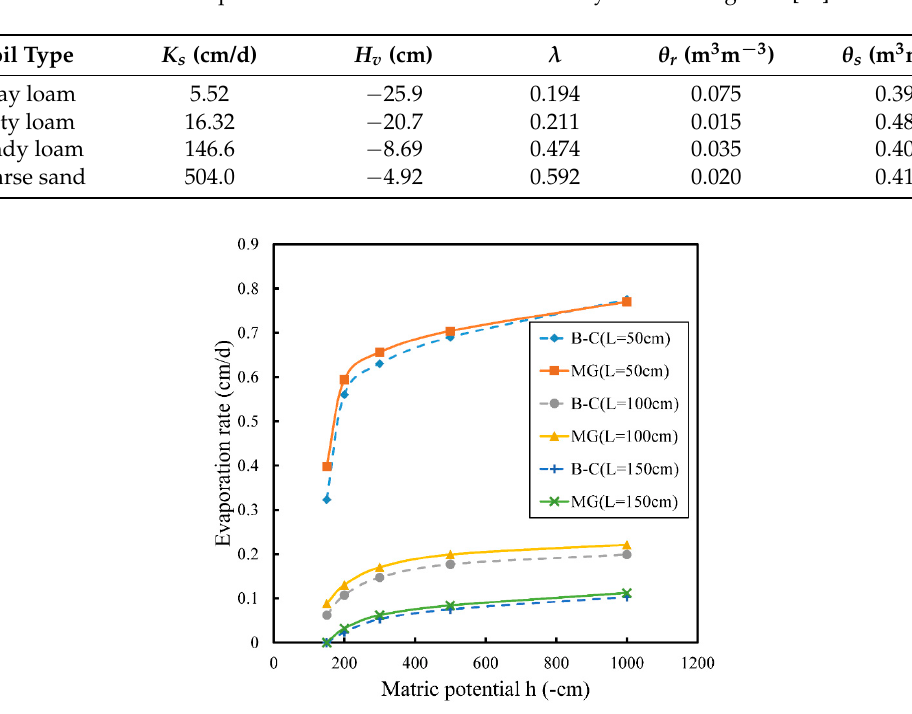
Figure. 2. The evaporation rate (cm/d) calculated by the modified Gardner [23] model and the Brooks–Corey [26] model versus the surface matric potential (-cm) for the Chino Clay (see Table 1). MG and B–C represent the modified Gardner’s [23] model and the Brooks–Corey [26] model in the figure, respectively.